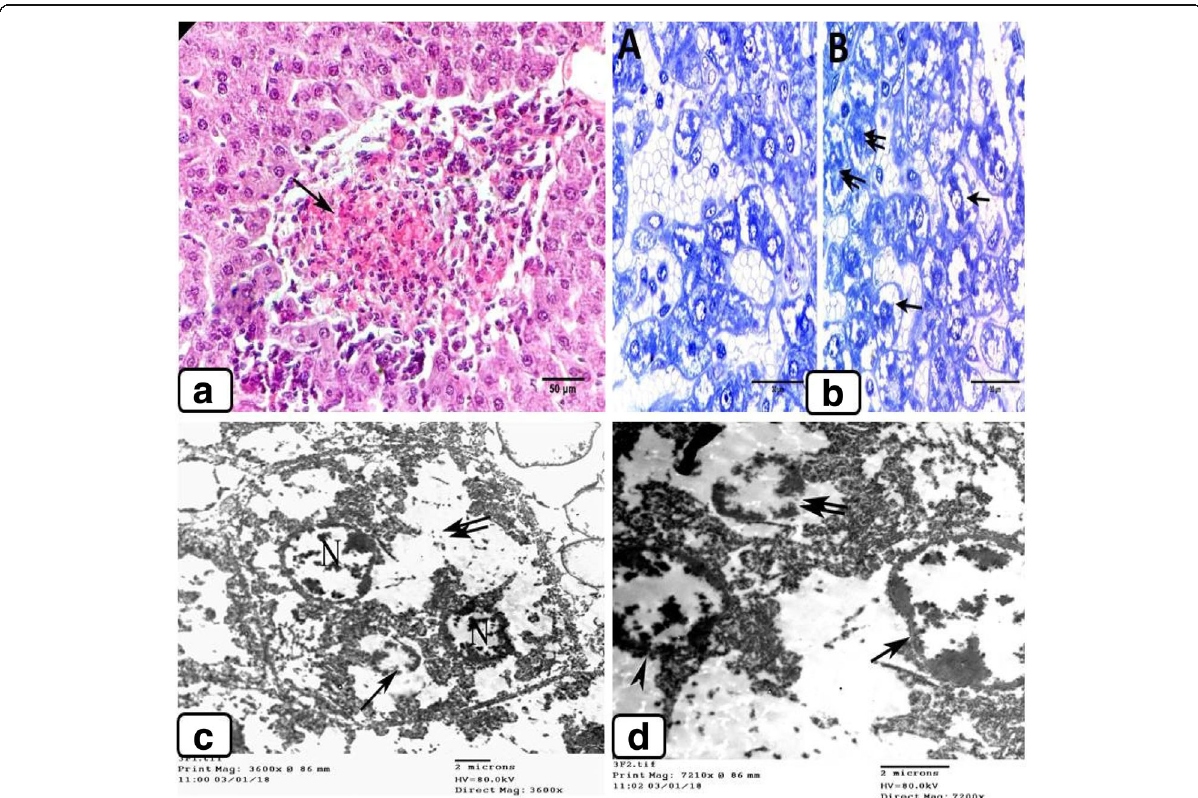
Fig. 8 F4 group liver showing a large necrotic area with leucocytic aggregation and hemorrhage (H&E). b F4 group liver showing A congested blood sinusoids and damage of their walls led to the fusion of their lumens (toluidine blue stain). B Most cells depleted from the cytoplasm ( ↑ ) and degeneration of most of the nuclei ( ↑↑ ) (toluidine blue stain). c Ultrastructure of hepatocytes showing three degenerated nuclei (N); one of them their nuclear membrane was damaged ( ↑ ). Large empty spaces due to the destruction of most cell organoids ( ↑↑ ). d Ultrastructure of hepatocytes showing three nuclei, one of them their nuclear membrane was damaged ( ↑↑ ), the other one showed separation between their inner and outer membrane ( ↑ ) while the last one appears degenerated